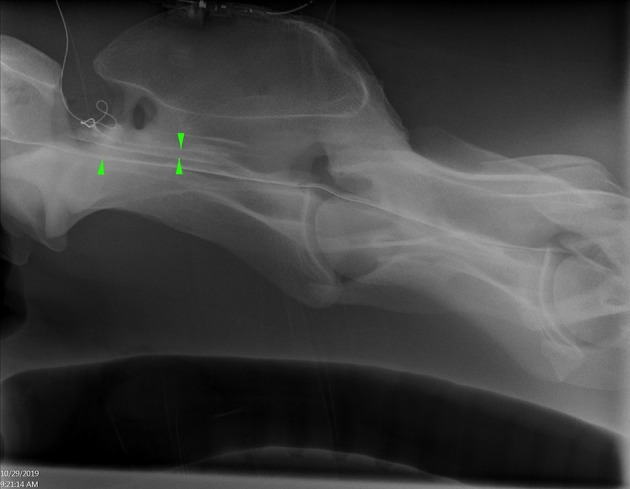
Lateral radiograph of caudal C1 to cranial C4 showing radiopaque catheter at the level of C1–2. Positive contrast outlines the ventral border of the spinal canal (single arrowhead) and a faint outline of the spinal cord (opposing arrow heads) (Horse 6).